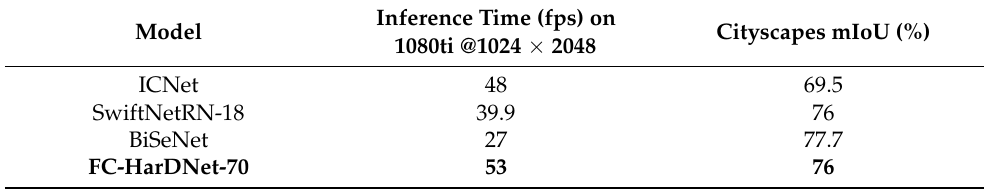
Table 2. Comparison of the performance of FC-HarDNet with other